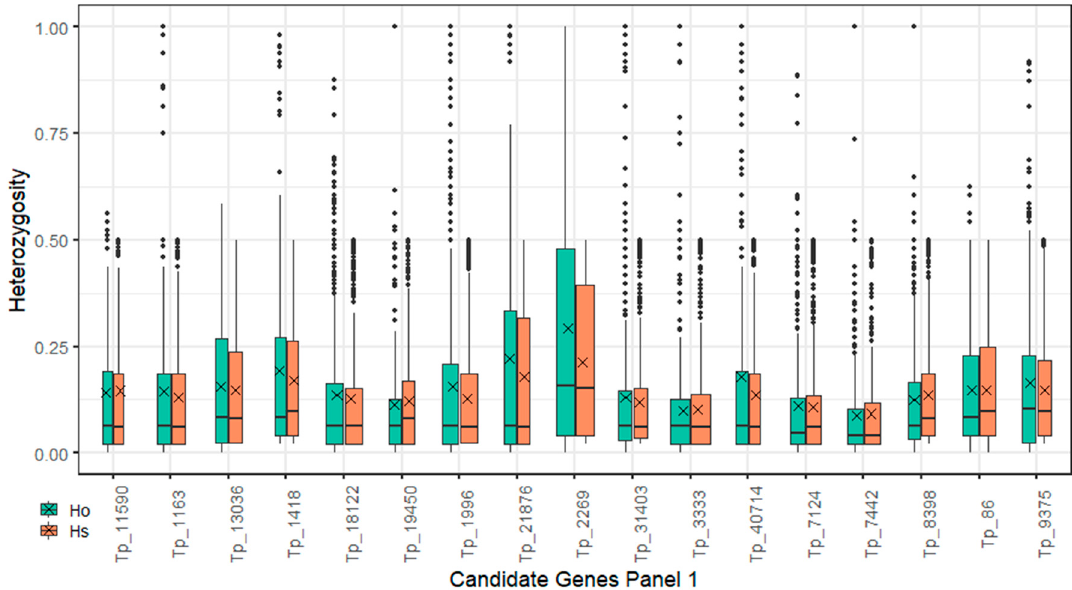
Figure 4. Boxplot of observed (Ho; blue boxes) and expected (Hs; orange boxes) heterozygosity of Panel 1 nitrogen fixation candidate genes. Hs expresses the level of genetic variability. Crosses indicate mean values. Horizontal lines in boxes indicate medians. Bottoms and tops of boxes indicate the first and third quartiles of the dataset. Whiskers indicate range of data but the maximum length of each is 1.5 times greater than the height of its box. Remaining points are outliers. The boxes are drawn with widths proportional to the square roots of the numbers of polymorphisms in targeted sequences.